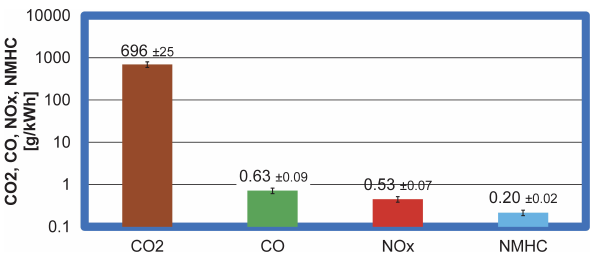
Figure 6: Average road exhaust emissions and average fuel con- sumption of a bus equipped with a diesel engine.